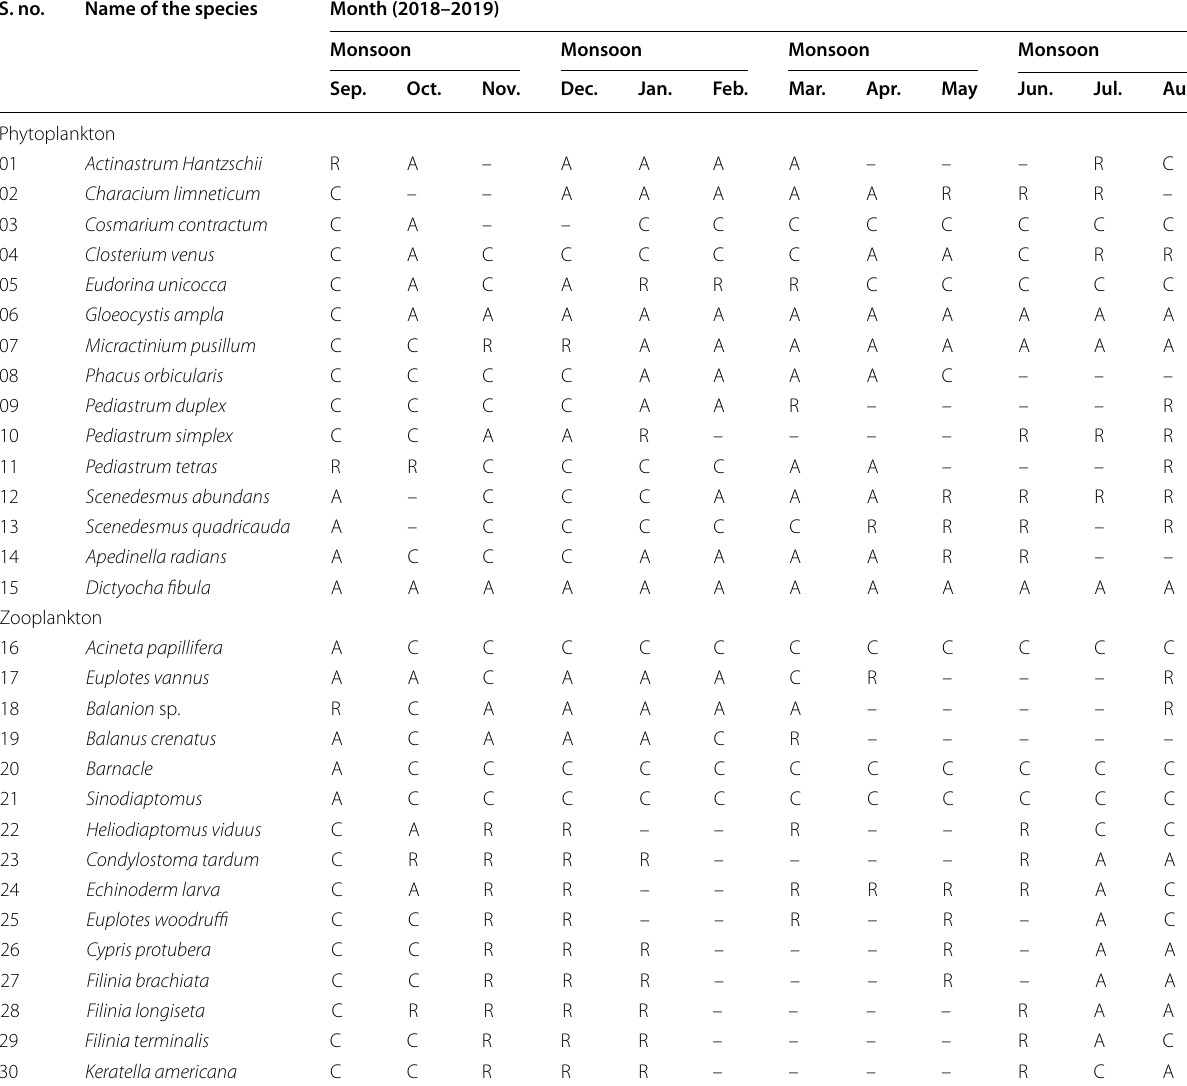
A, Abundance; C, Common; R, Rare; –, Absent